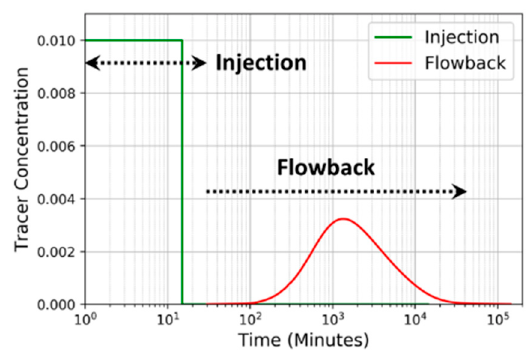
Figure 5. Tracer response curve from a slug injection tracer flowback.